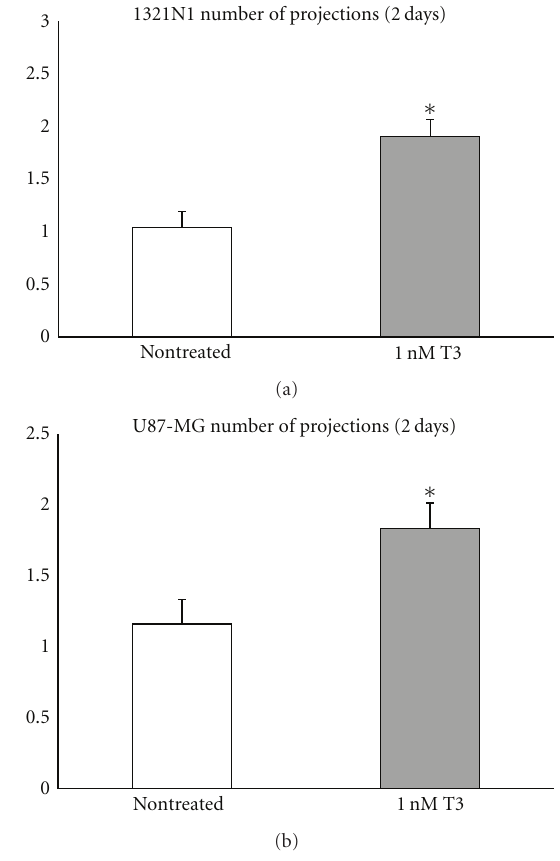
Figure 1: T3 induced cell re-di ff erentiation as indicated by the sig- nificant increase in the ratio of number of projections to total cell number both in 1321N1 cells (a) and U87-MG cells (b) at 2 days. Data were derived from approximately 100 cells in each group. ∗ P < 0 . 05 versus